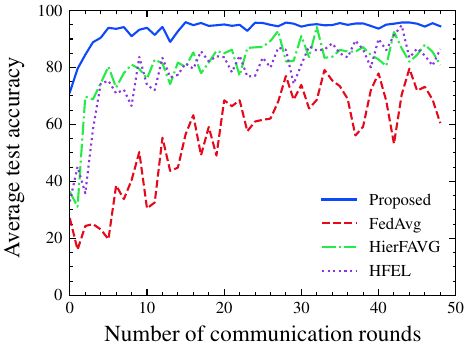
Figure 3. Test accuracy of the various FL algorithms over communication rounds for Scenario I.